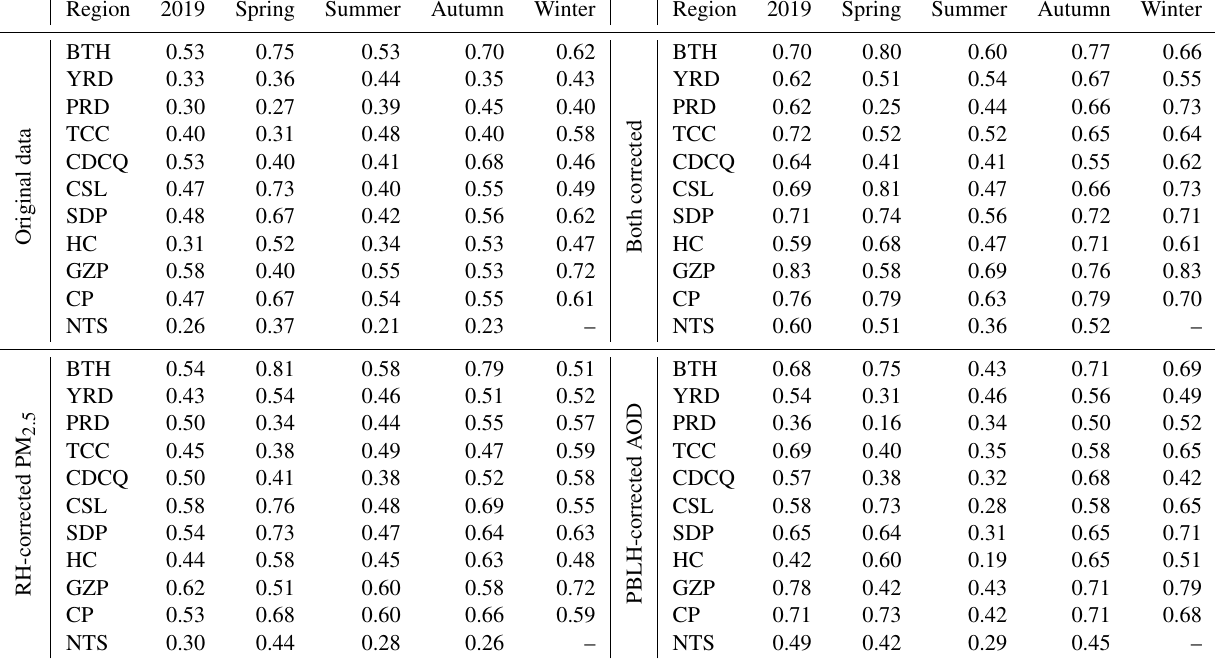
Table 1. Correlation coefficients between (RH-corrected) PM 2 . 5 and (PBLH-corrected) AOD over various urban agglomerations in China during the study period, including Beijing–Tianjin–Hebei (BTH), Yangtze River Delta (YRD), Pearl River Delta (PRD), Triangle of Central China (TCC), Chengdu–Chongqing (CDCQ), central and southern Liaoning (CSL), Shandong Peninsula (SDP), Harbin–Changchun